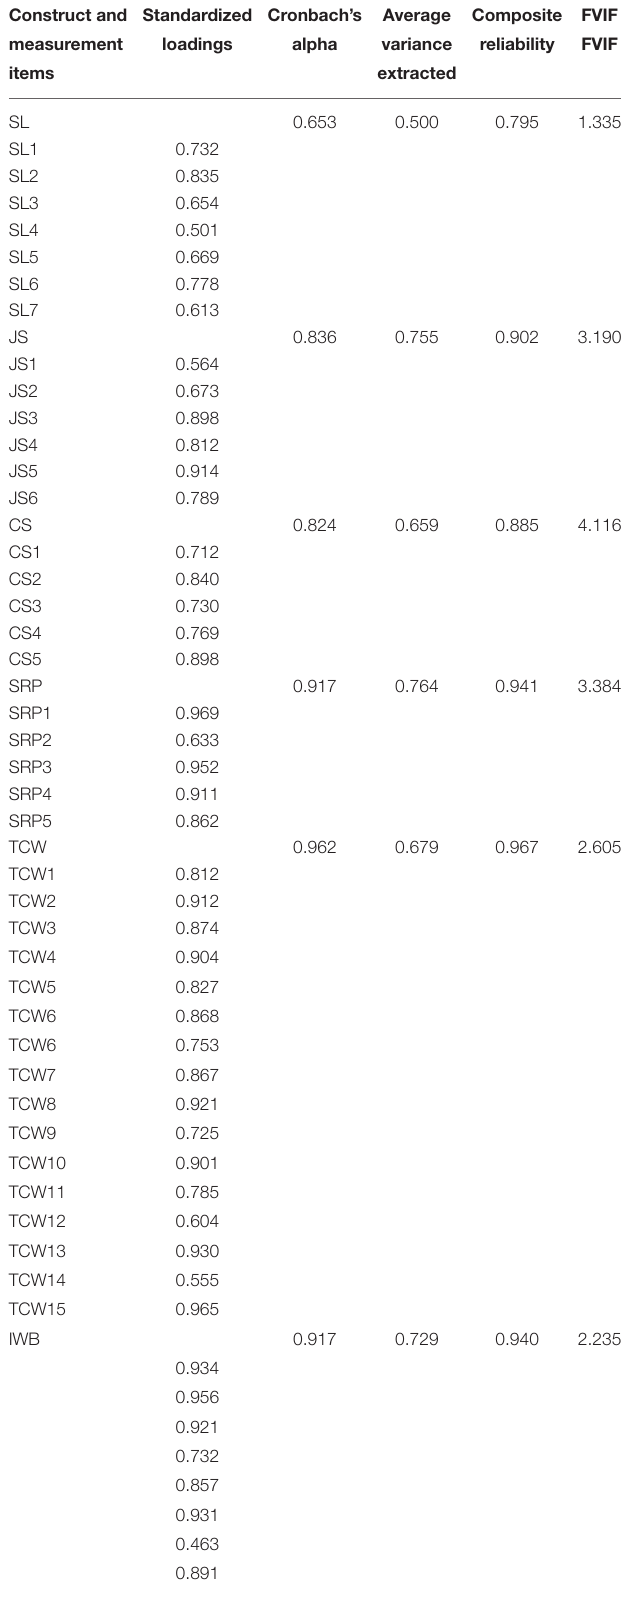
TABLE 1 | Model measure assessment